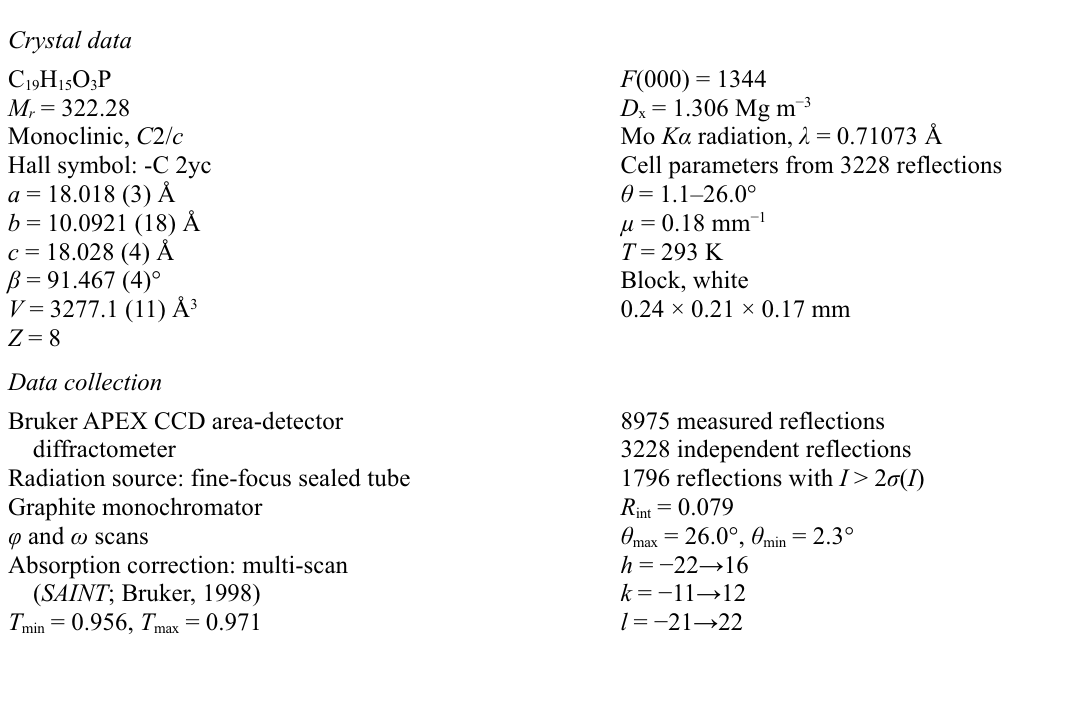
View of the chain structure of the title compound; hydrogen-bonds are drawn as dashed lines. 4-(Diphenylphosphinoyl)benzoic